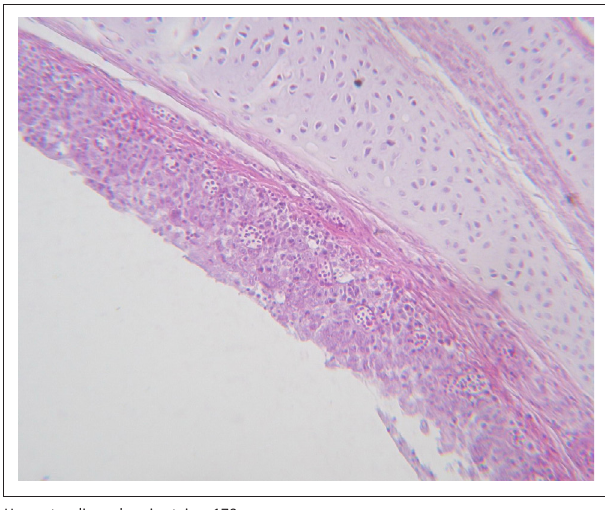
Haematoxylin and eosin stain × 150. FIGURE 4: Congestion and haemorrhage in lung tissue at 4 days post-